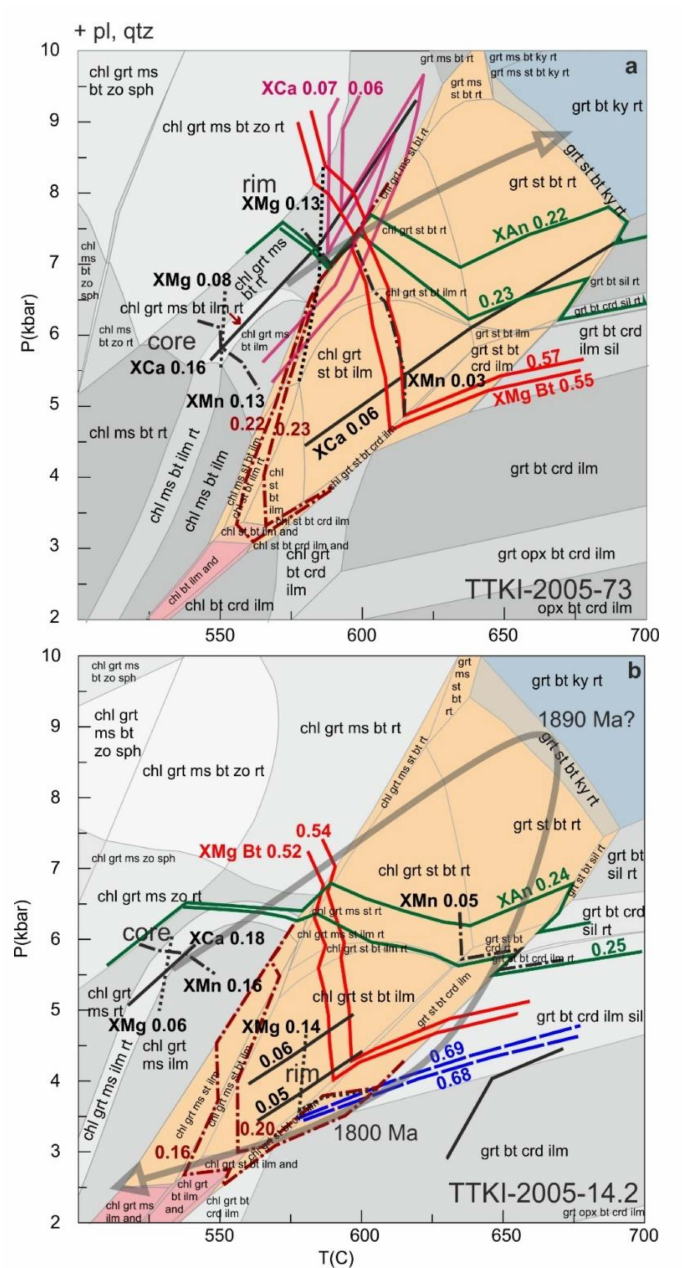
Figure 12. PT pseudosections for the samples TTKI-2005-73 ( a ) and TTKI-2005-14.2 ( b ). For clarity, some of the smallest fields for mineral assemblages are left out. The figure also shows the X Mg (dashed), X Mn (dash-dot) and X Ca (solid black lines) isopleths of the analysed garnet cores and rims, and the X Mg and X Ca isopleths for biotite (red lines) and plagioclase (green lines), respectively, and the X Mg isopleths of cordierite in the sample TTKI-2005-14.2 (dashed blue lines). The areas with brownish shades show the stability fields of staurolite, those with bluish shades show the fields for kyanite assemblages and those with pink shades show the fields of andalusite. The grey arrow in Figure 12b TTKI-2005-14.2 displays the possible Proterozoic PT path of the Tuntsa